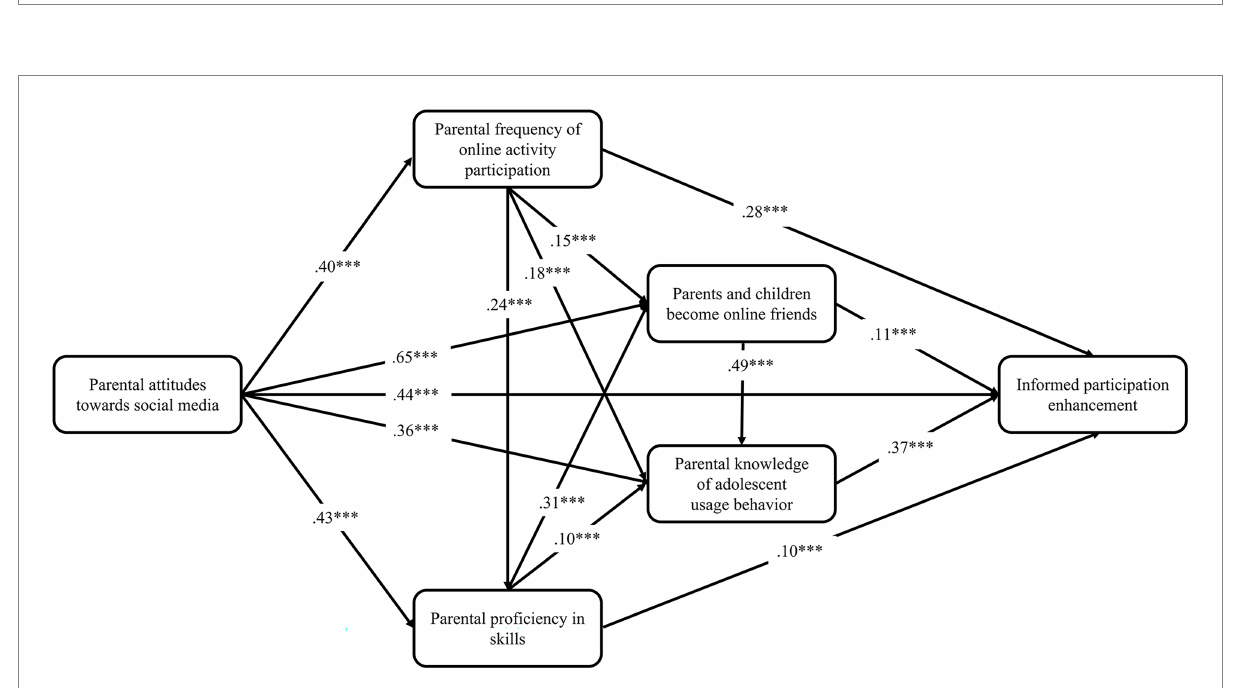
FIGURE 4 Predictive path coefficients of informed participation enhancement. * p < 0.05, ** p < 0.01, *** p < 0.001.